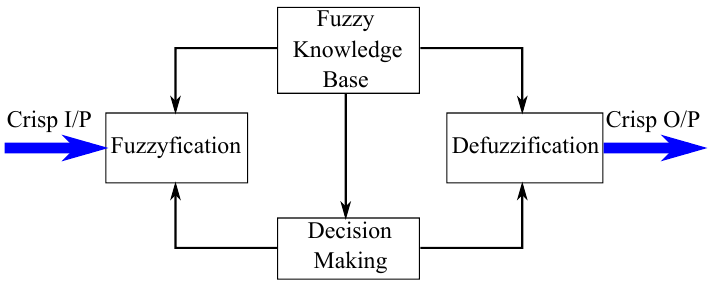
Figure 42. A generic Fuzzy controller block